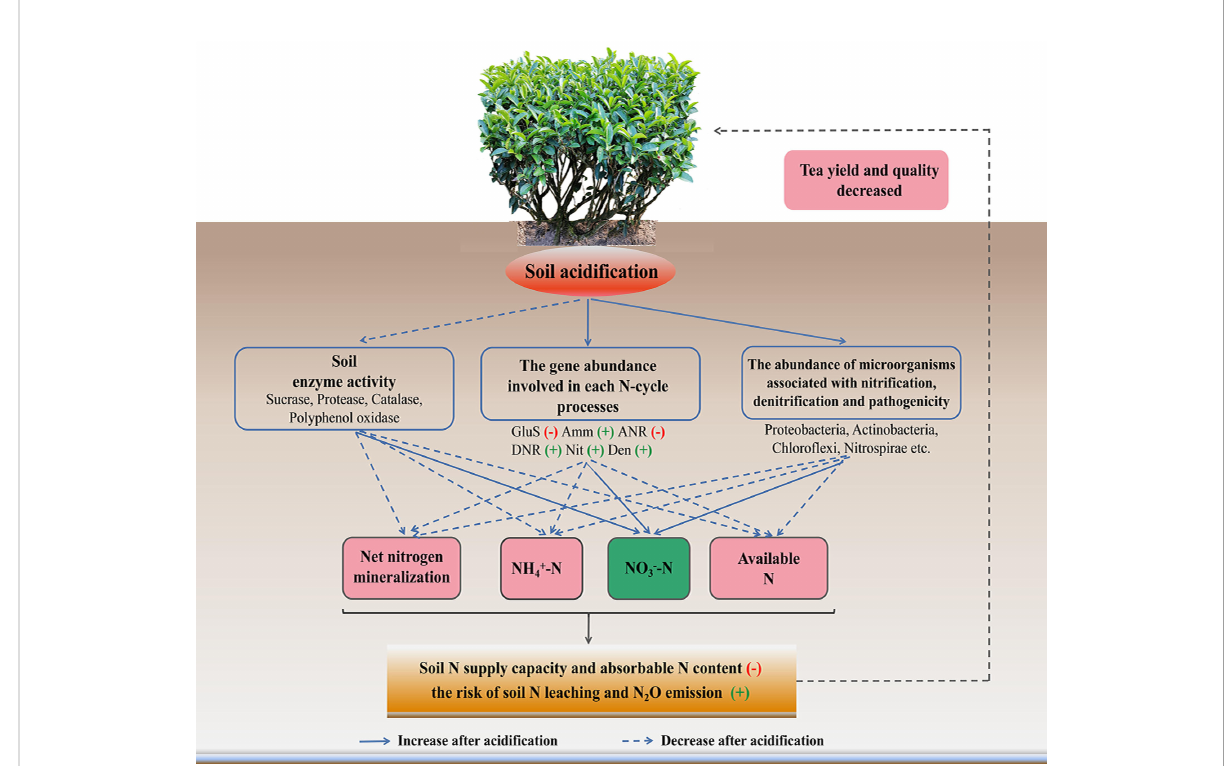
FIGURE 7 Model showing the mechanism of soil acidi fi cation on soil nitrogen form and transformation in tea gardens. The blue dotted and solid lines represent a decrease and increase in an indicator, respectively. Red minus sign indicates upregulated, while green plus sign indicates downregulated. GluS, glutamate synthesis; Amm, ammoni fi cation; ANR, assimilatory nitrogen reduction; DNR, dissimilatory nitrogen reduction; Nit, nitri fi cation; Den, denitri fi